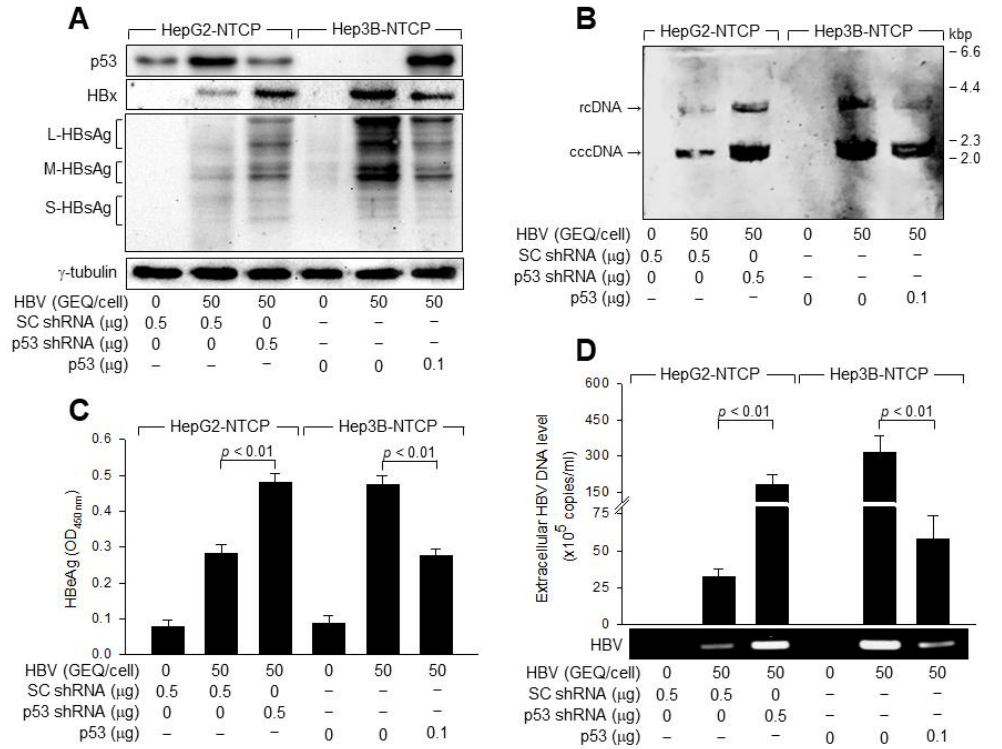
Figure 2. p53 inhibits HBV replication in human hepatoma cells. HepG2-NTCP and Hep3B-NTCP cells were transfected with the indicated amounts of scrambled (SC) shRNA, p53 shRNA, or p53 expression plasmid for 24 h, and then either mock-infected or infected with HBV at 50 GEQ/cell for 4 days. ( A ) Levels of the indicated proteins in cell lysates were measured by Western blotting. ( B ) Southern blotting was performed to detect HBV DNA extracted from the infected cells using the Hirt method. ( C ) The levels of HBeAg released from infected cells were measured by ELISA ( n = 4). ( D ) Levels of HBV particles released from infected cells were determined by conventional PCR and qPCR ( n = 6).